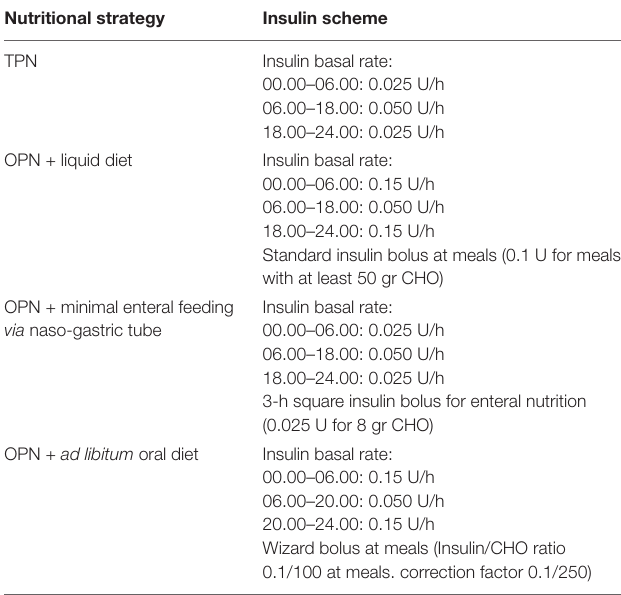
TABLE 1 | Different insulin schemes according to different nutritional strategies. Nutritional strategy Insulin